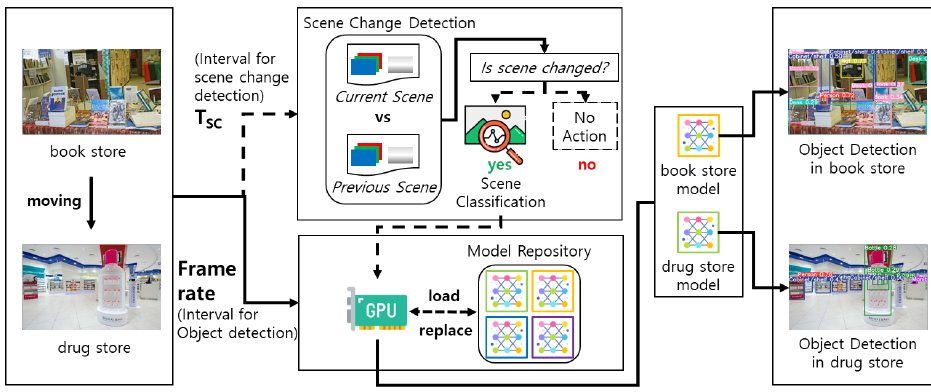
Figure 5. Process of lightweight scene classification in